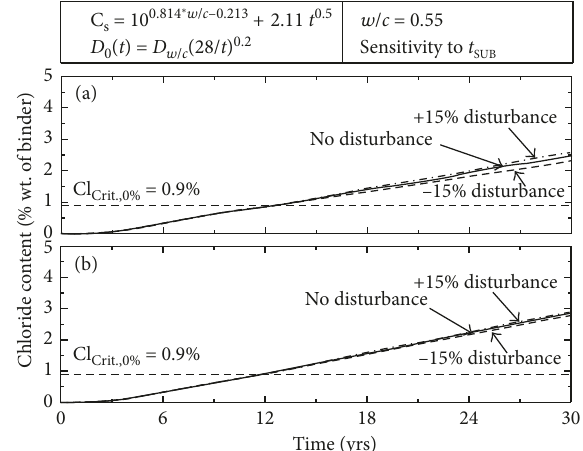
Figure 10: Chloride content for silane-treated concrete without and with disturbance on t SUB